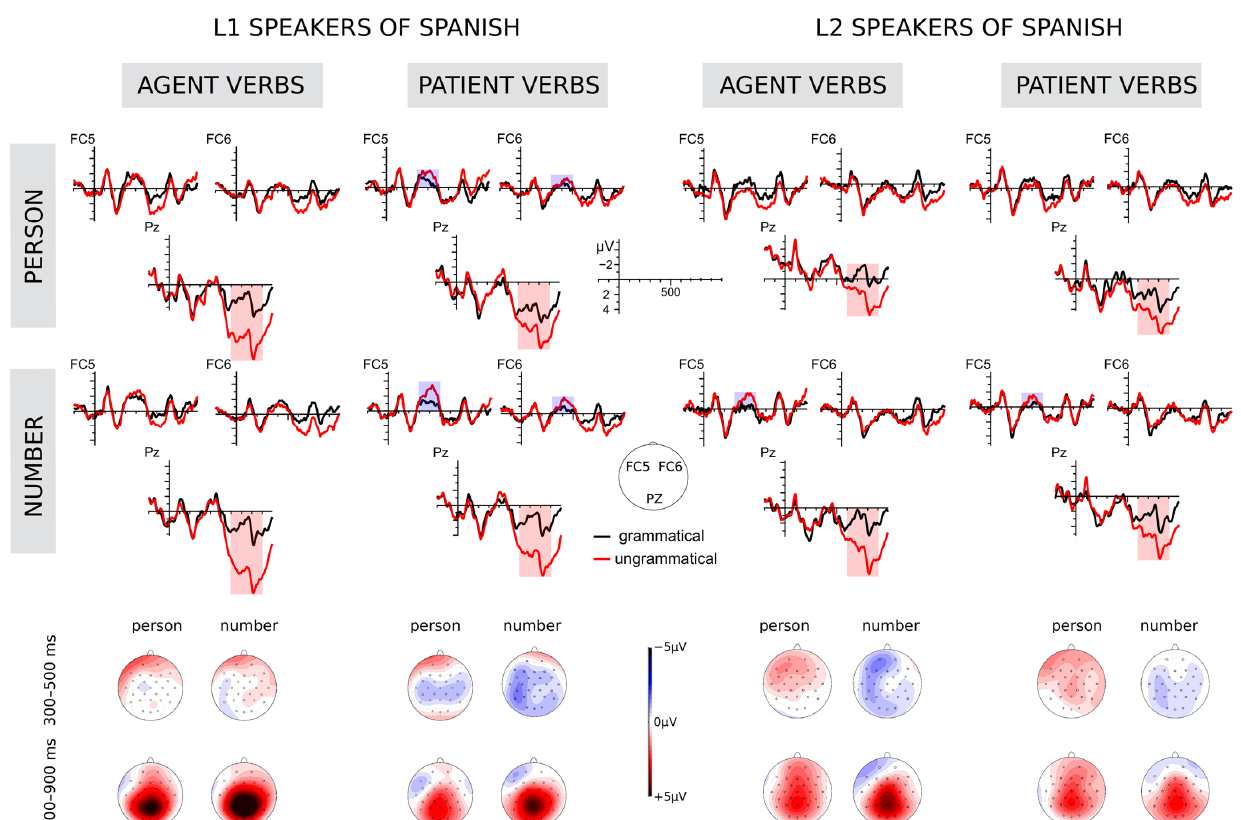
Figure 1. ERPs elicited at the critical word position in all conditions. Red lines represent the ungrammatical stimuli, while the black lines represent the grammatical stimuli. Significant differences between the grammaticality conditions are highlighted by the blue and red areas. Topographical amplitude difference maps for the grammaticality effect below were calculated as the average subtracting grammatical sentences from ungrammatical ones.